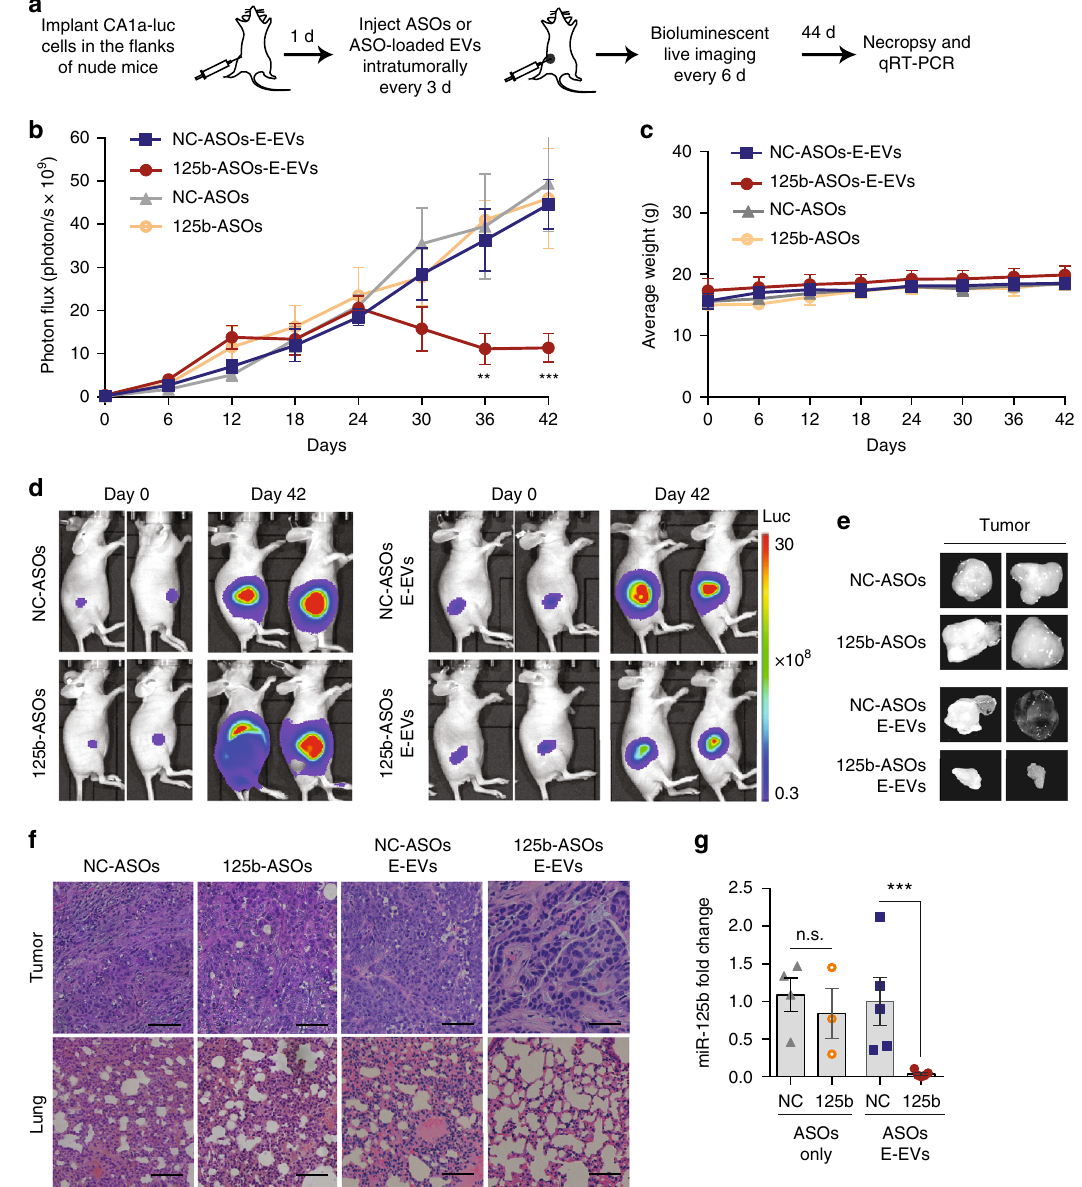
Fig. 5 Treatment with ASOs-loaded RBCEVs suppresses tumor growth by miR-125b knockdown. a Schema of ASOs delivery to nude mice bearing breast cancer xenografts. b Average bioluminescent photon fl ux of the tumors treated every 3 days with intratumoral injection of 8.25 × 10 11 RBCEVs containing NC/125b-ASOs (E-EVs, n = 8 mice) or with 400 pmol NC/125b-ASOs ( n = 6 mice), determined using IVIS (mean ± SEM). c Average weight of the mice (mean ± SEM). d Representative images on day 0 and 42. Bioluminescence is shown in pseudocolored radiance. e Representative pictures of the tumors on day 44. f Representative H & E staining images of the tumor and the lung collected on day 44. Scale bar, 50 μ m. g miR-125b fold change relative to U6b RNA and NC condition in the tumors after 44 days of treatments, determined using Taqman qRT-PCR (mean ± SEM). P values were determined using